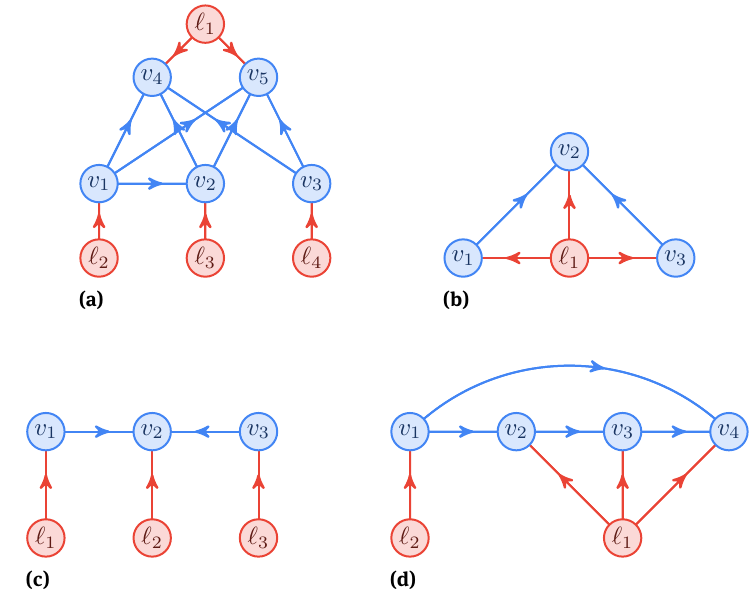
Figure 20: Examples of exo-simplicial causal structures which are observationally equivalent to their respective counterparts in Figure